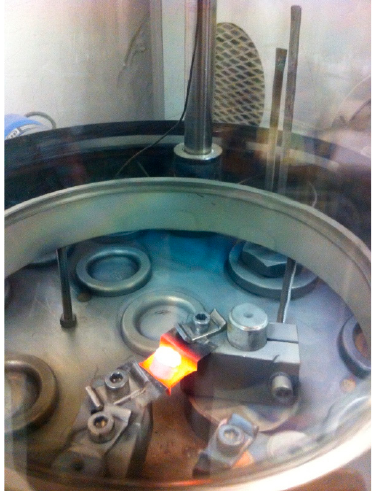
Figure 1. 6 LiF being evaporated under vacuum from a hot crucible.